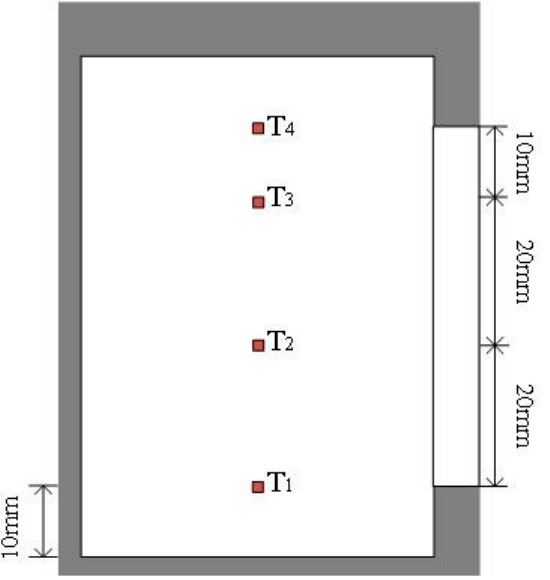
Figure 3. Temperature measuring point location distribution.